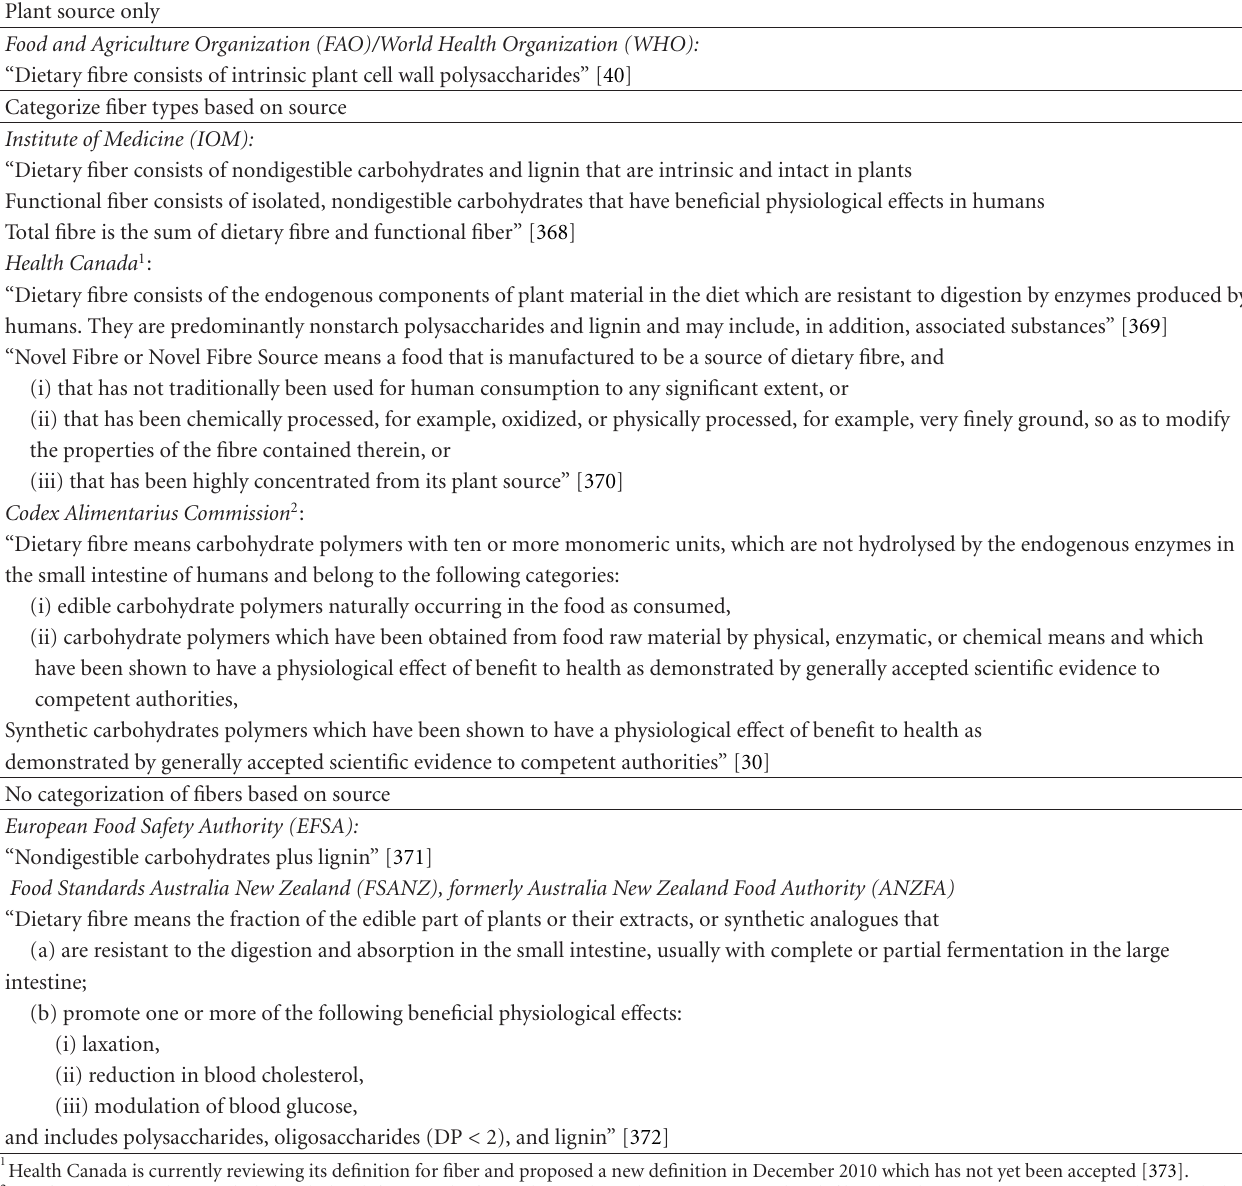
Table 1: Categorization of recent definitions of fiber based on whether or not a distinction in dietary fiber source is made. Plant source